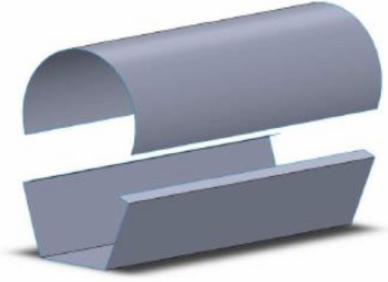
Figure 6. Exploded view of the